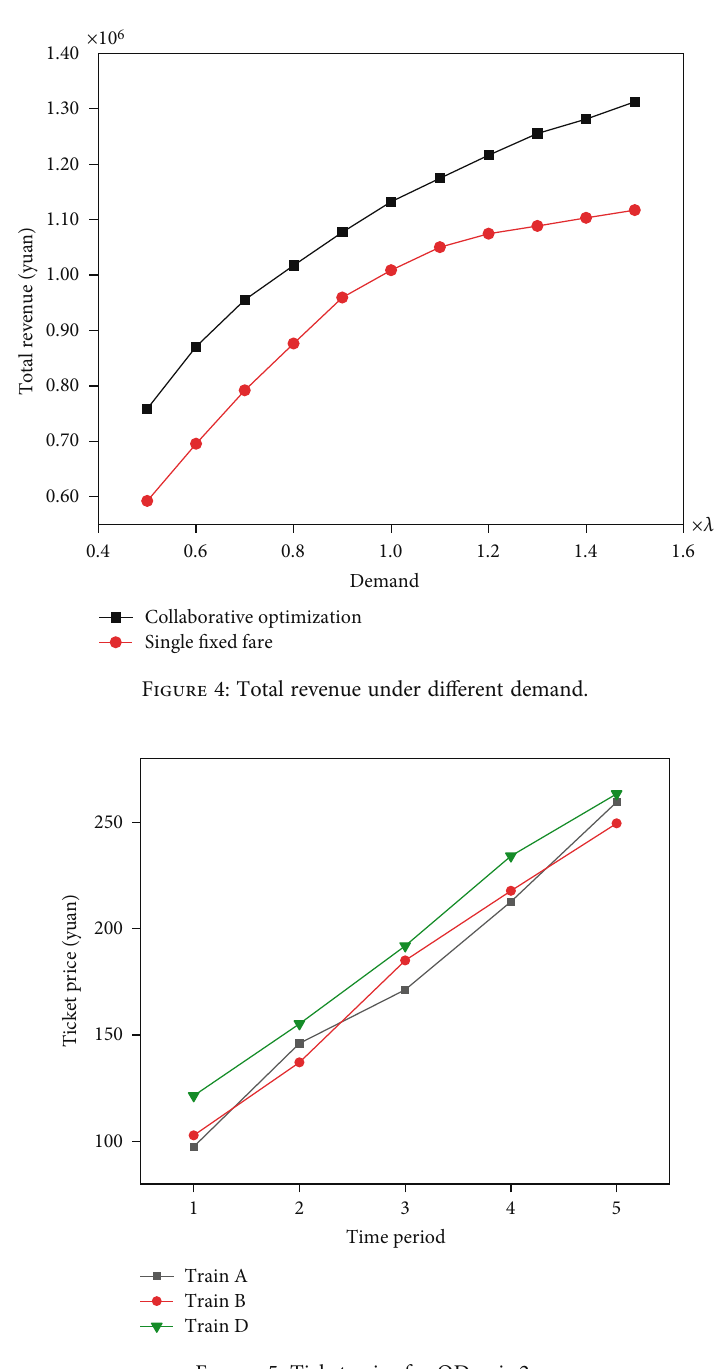
Figure 5: Ticket price for OD pair